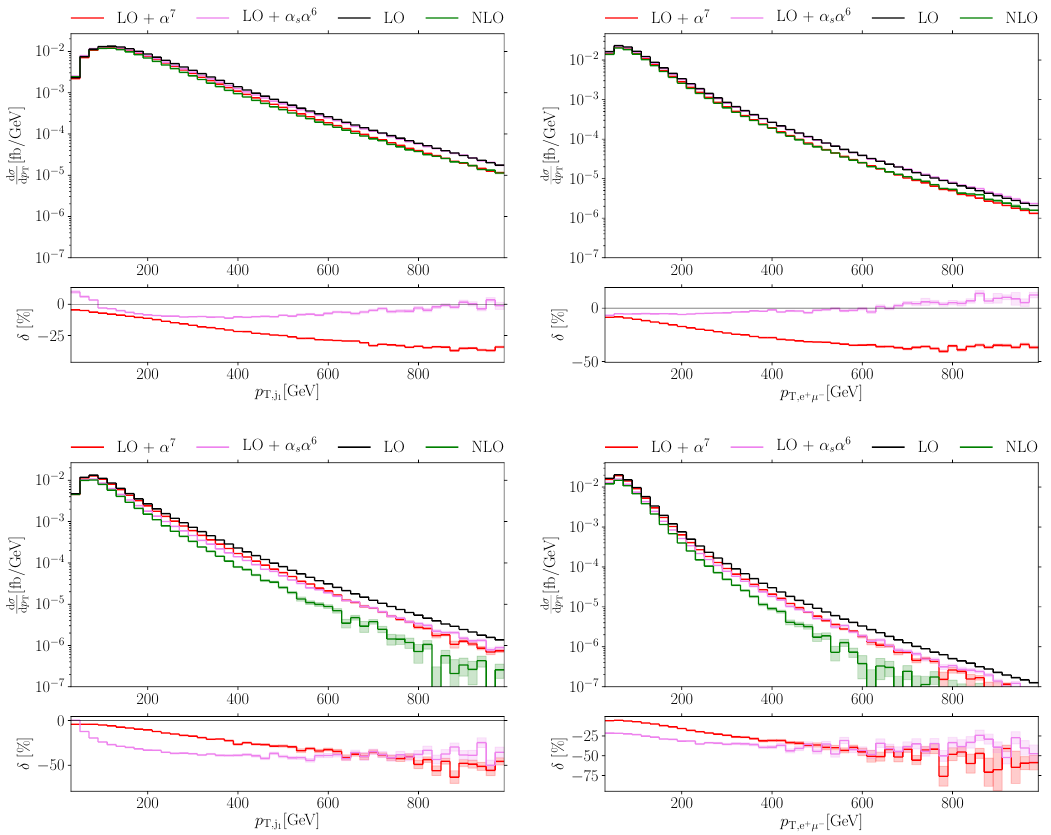
Figure 9. Differential distributions at NLO in the transverse momentum of the hardest jet (left) and the two charged leptons (right) in the VBS (top) and the Higgs setup (bottom). The upper (cid:0) (cid:1) panels show the absolute EW contribution at α 6 , the sum of the EW contribution and the EW O (cid:0) (cid:1) corrections of α 7 , the sum of the EW contribution and the QCD corrections of O the sum of all three contributions. The lower panels show the relative EW and QCD corrections normalised to the LO EW contribution. Shaded bands denote integration